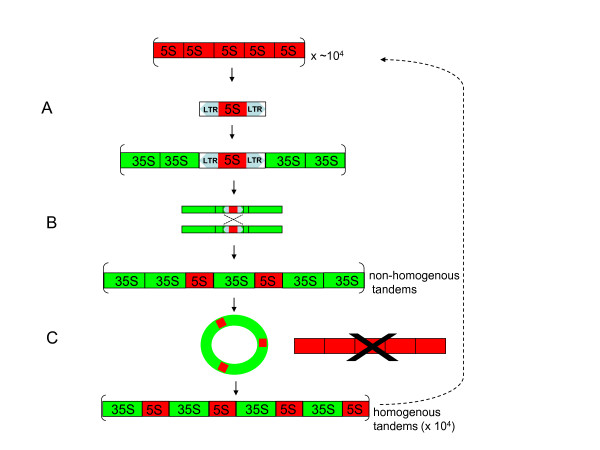
Hypothetical model illustrating a cascade of events accompanying 5S rDNA evolution in Asteraceae. (A) Mobilisation of 5S genes by a retrotransposition event and their integration within the 35S unit; (B) short (< 100 units) tandems of 35S-5S repeats generated by intralocus non-homologous recombination; inactivation of retroelement activity by mutation and/or epigenetic silencing. (C) amplification and spreading of 35S-5S arrays across the chromosomes mediated by mechanisms such rolling circle replication and reintegration of covalently linked circles. Loss of arrays of unlinked units. Green rectangles - units of 35S genes, red rectangles - units of 5S genes. Dotted line depicts the reversion process from linked to unlinked genotype. For the simplicity, proportions of gene sizes are not in scale.